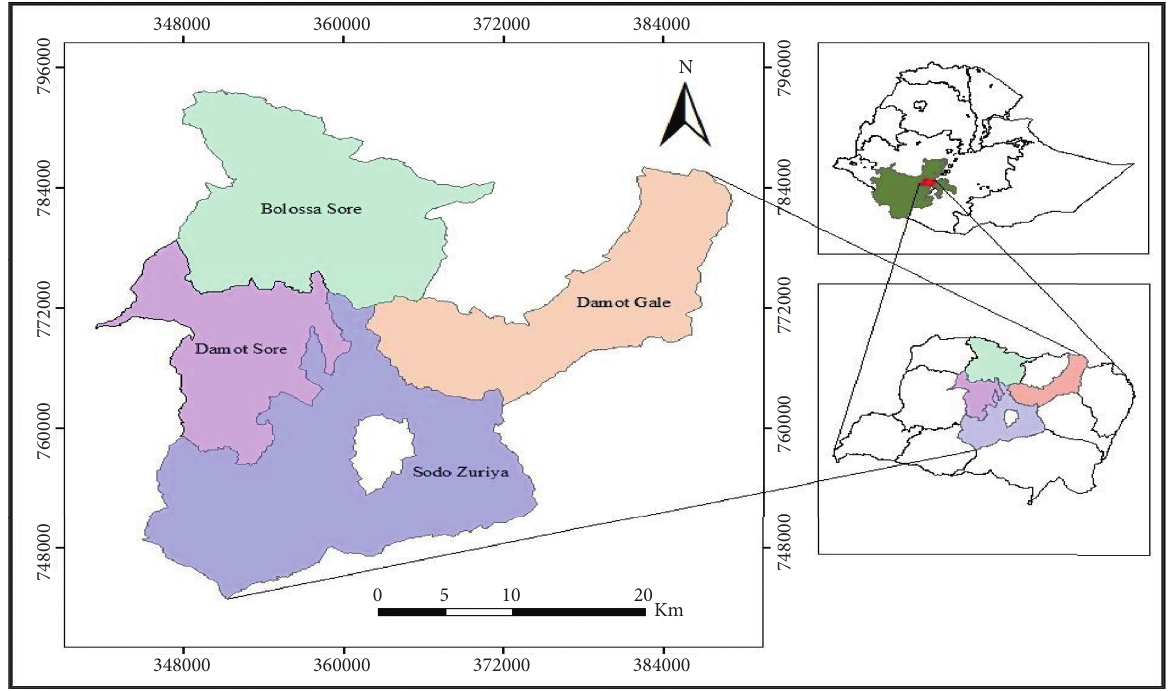
Figure 1: Location of the study sites, Wolaita districts, southern